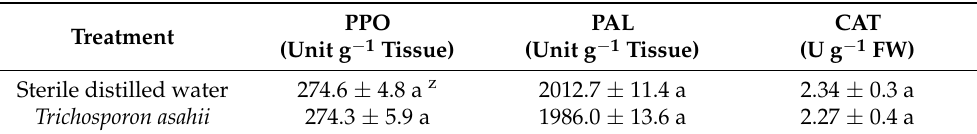
Table 7. Effects of treatments (sterile distilled water and Trichosporon asahii ) on polyphenol oxidase (PPO), phenylalanine ammonia-lyase (PAL) and catalase (CAT) on Solo papaya ( Carica papaya L.) during storage at 28 ◦ C for eight